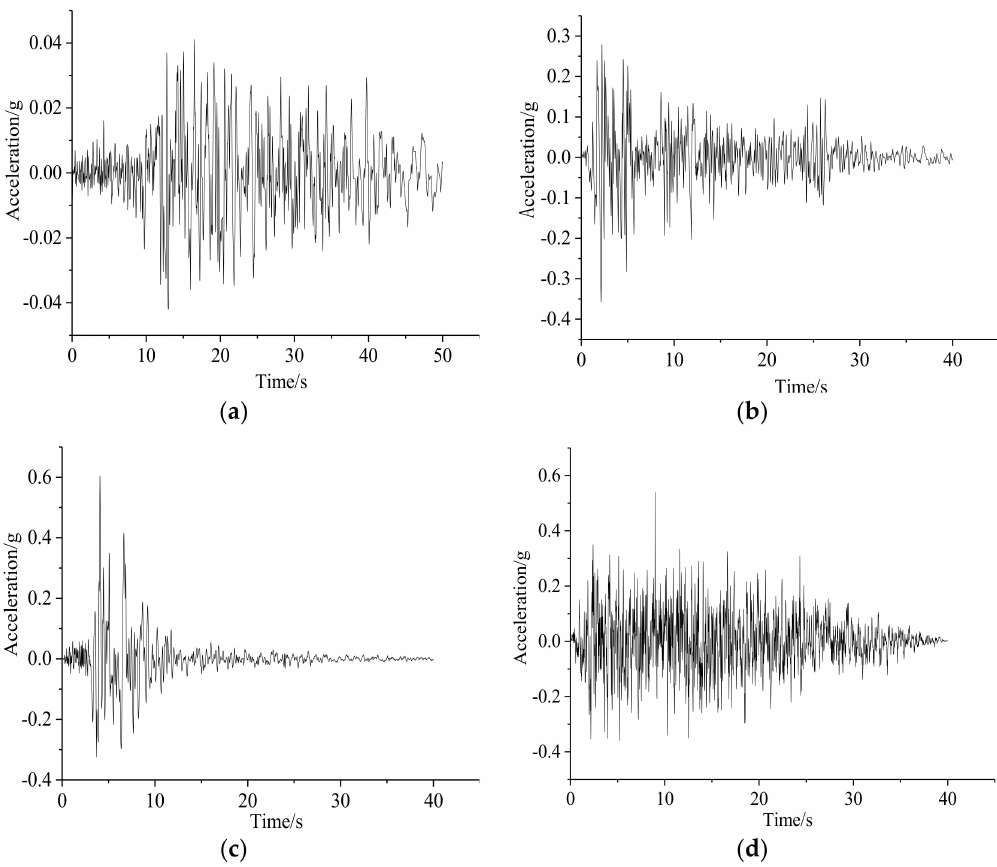
Figure 12. Acceleration-time curves: ( a ) HOLLYWOOD, ( b ) ELCENTRO, ( c ) NRIGDE and ( d ) artificial wave.